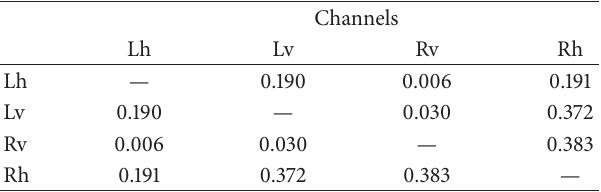
Table 3: Cross-correlation coefficients—elevation angle of 4.3 ∘ with wider antenna distance.